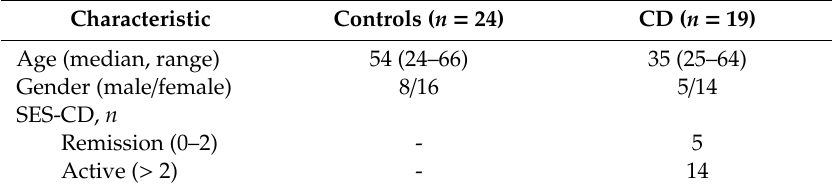
Table 1. Characteristics of the enrolled Crohn’s disease (CD) population.